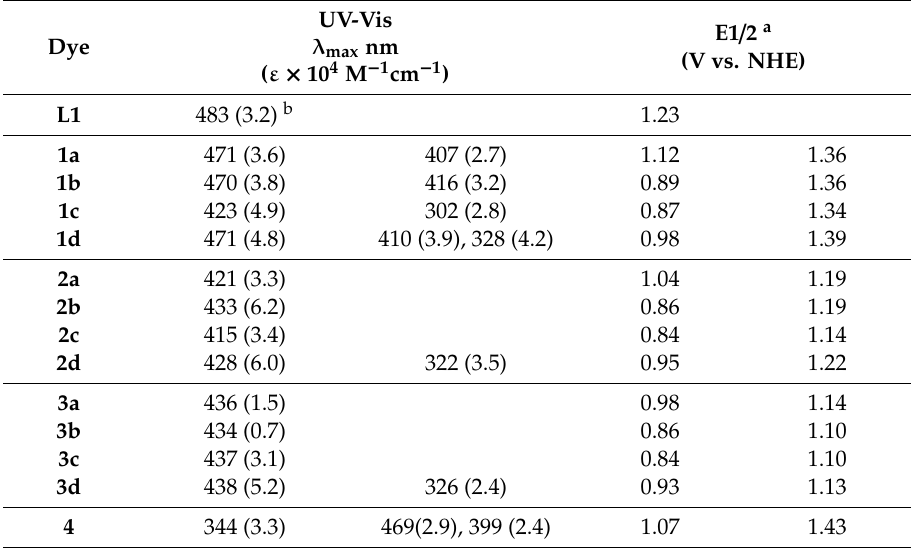
Table 1. Physiochemical properties of DSSC dyes reported